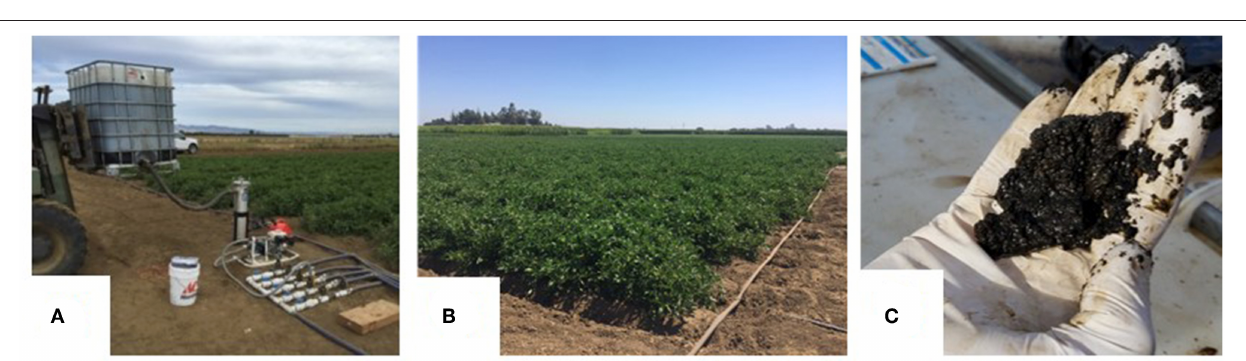
FIGURE 2 | (A) Biofertilizer delivery including the tote storing biofertilizer material, a bag filter to ensure no particles larger than the emitters passed though, and a pump-driven injection system; (B) The tomato field before harvest; and (C) Solids collected from the 150 µ m bag